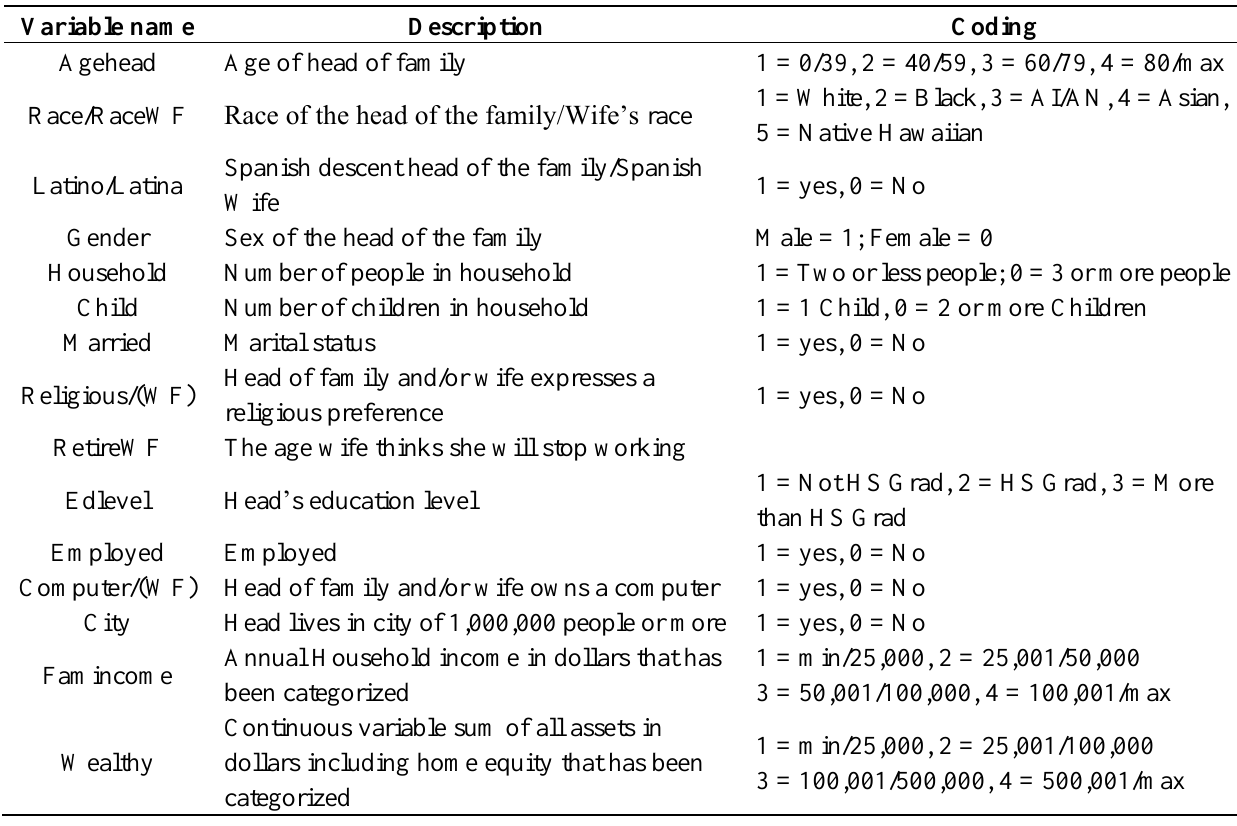
Table 2. Independent variable